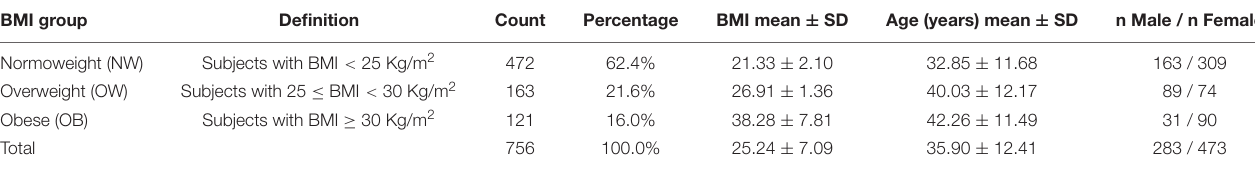
TABLE 1 | Frequency and percentage distributions of the BMI groups along with descriptive statistics of BMI, age, and gender within the BMI groups. BMI group